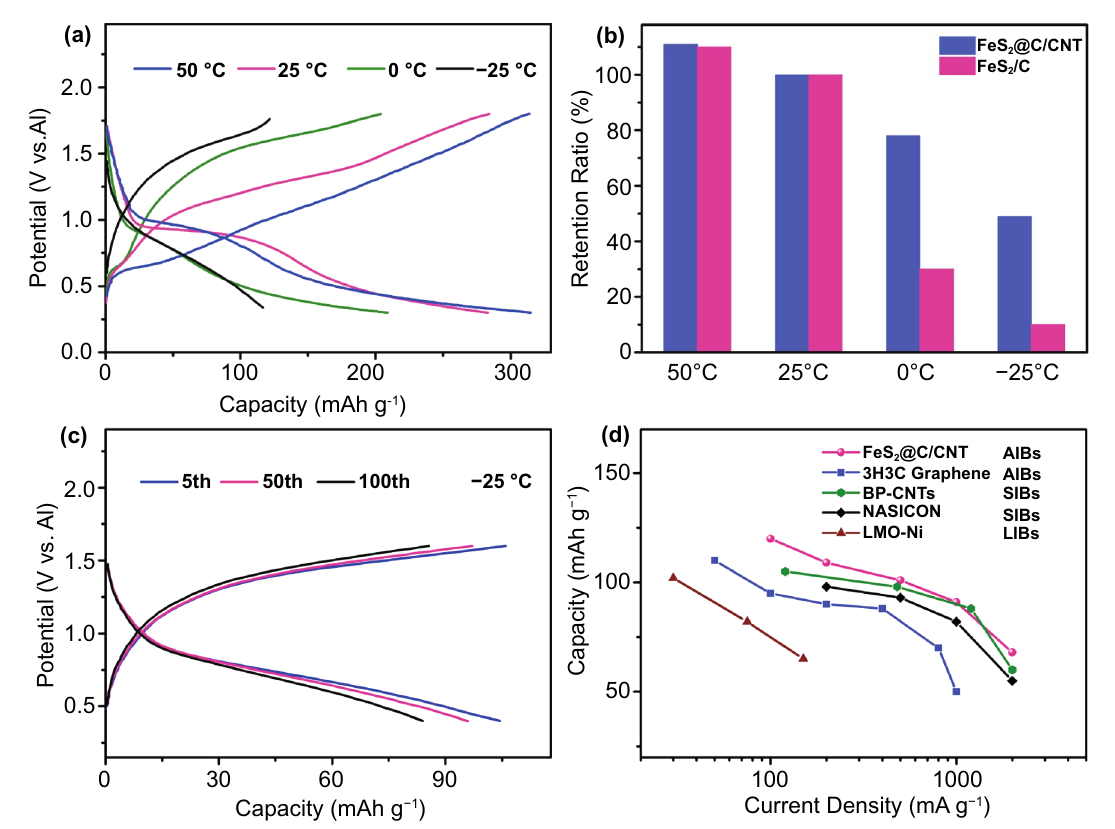
Fig. 4 a Discharge–charge curves of the FeS 2 @C/CNT under a range of temperatures at a current density of 100 mA g −1 . b Capacity retention of FeS 2 @C/CNT and FeS 2 /C electrodes at a current density of 100 mA g −1 from −25 to 50 °C. c 5 th , 50 th , and 100 th charge–discharge curves of the FeS 2 @C/CNT under −25 °C at a current density of 100 mA g −1 . d Rate capacity of FeS 2 @C/CNT in AIBs and other representative low- temperature electrode in AIBs, SIBs, and LIBs at low temperature (~ −25 °C) [18,